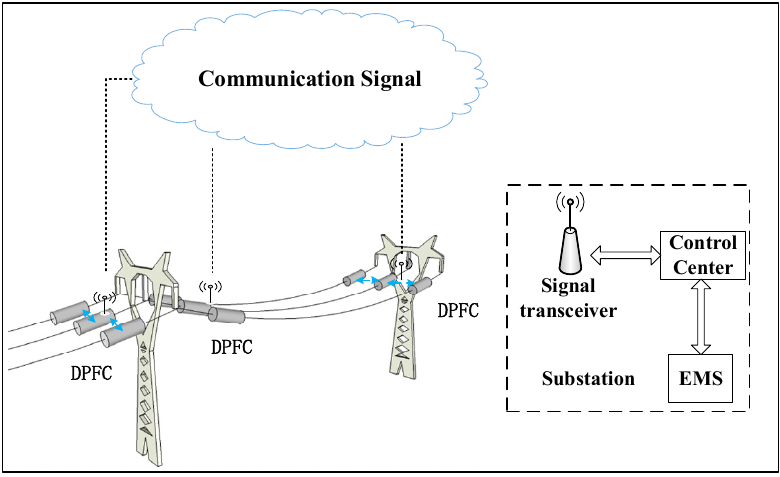
Figure 1. Distributed power flow controller (DPFC) deployed on transmission line.